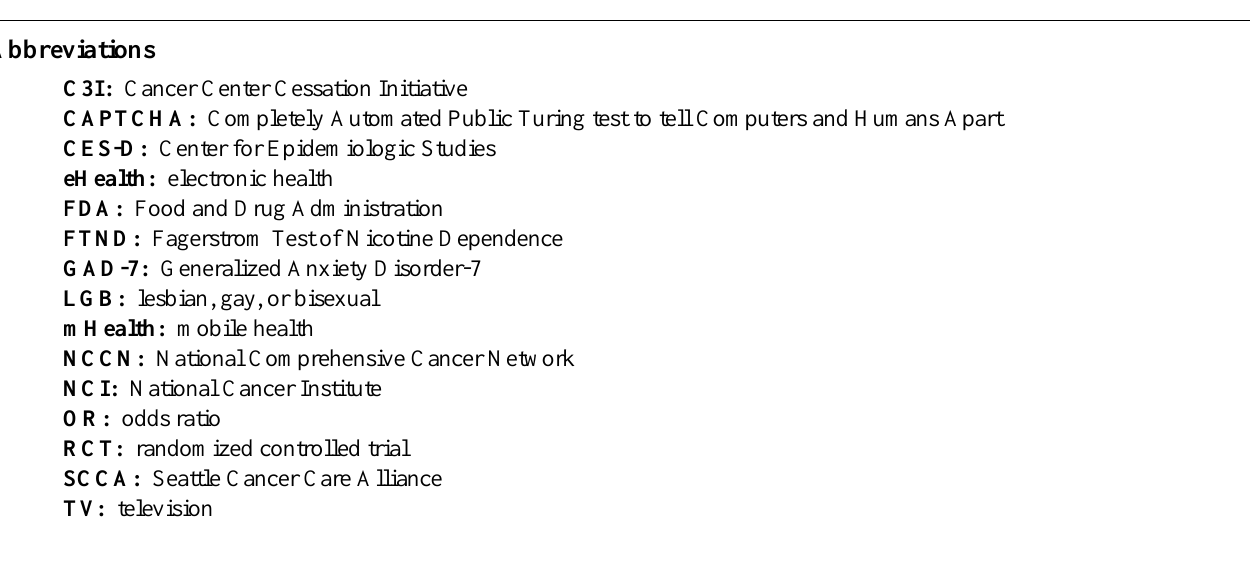
C3I: Cancer Center Cessation